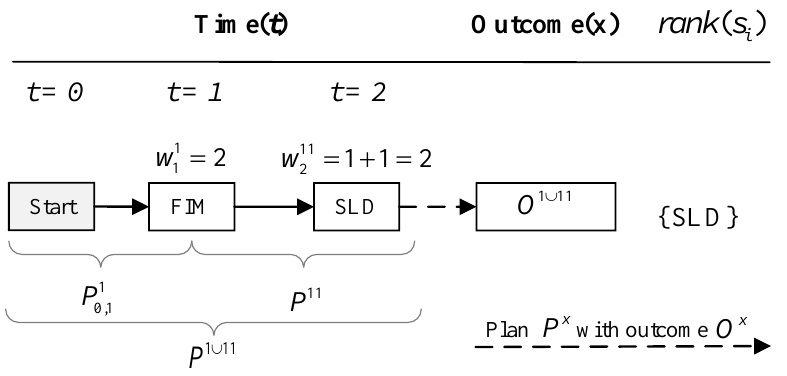
Figure 14. The second search tree after re-planning starting at time step t = 2 with the plan P 1 ∪ 11 .